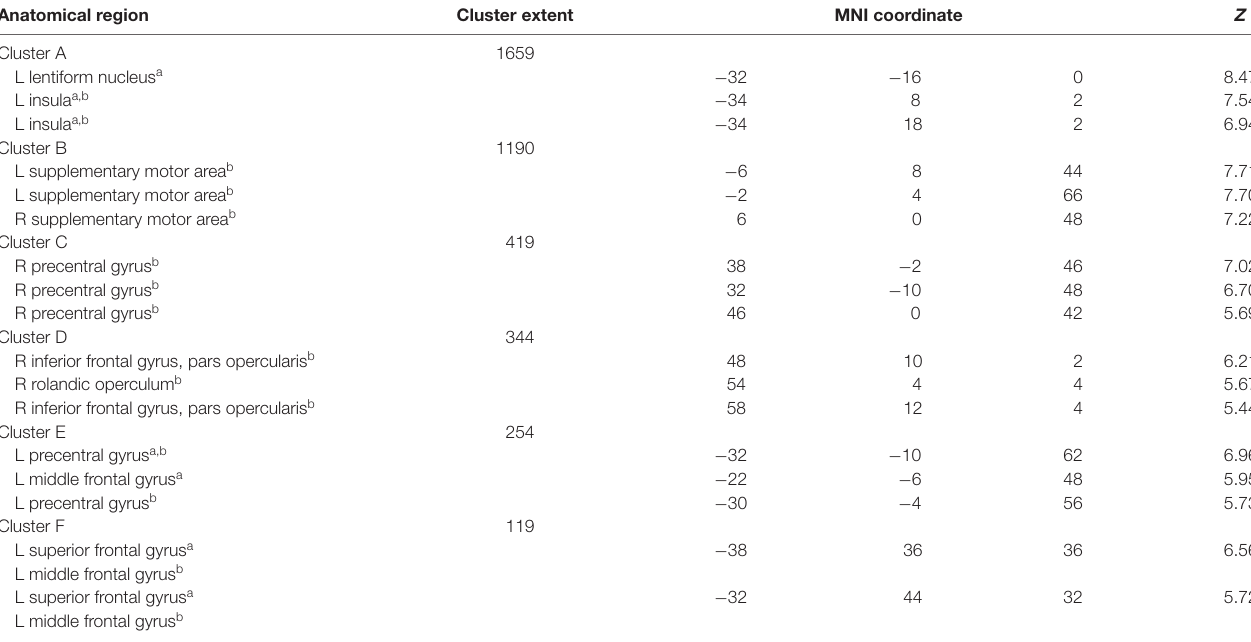
TABLE 2 | Effect of the balance training on brain activity during AO+MI in the training group. Anatomical region Cluster